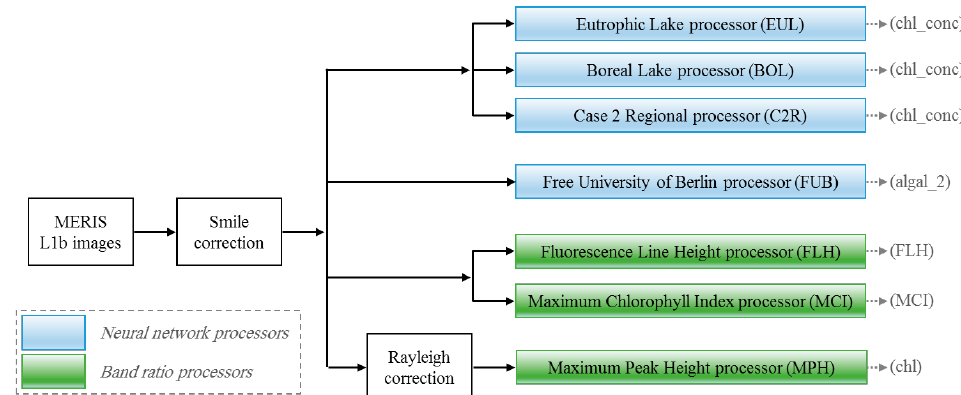
Figure 4. Processing flowchart of MERIS L1b images to retrieve chlorophyll-a concentrations or indices related to chlorophyll-a concentrations using neural network and band height processors. chl_conc indicates the chlorophyll-a (Chla) concentration retrieved from the EUL, BOL, and C2R processors; algal_2, and chl stand for the retrieved Chla of FUB and MPH processors, respectively; and FLH and MCI denote indices correlated with Chla concentrations.